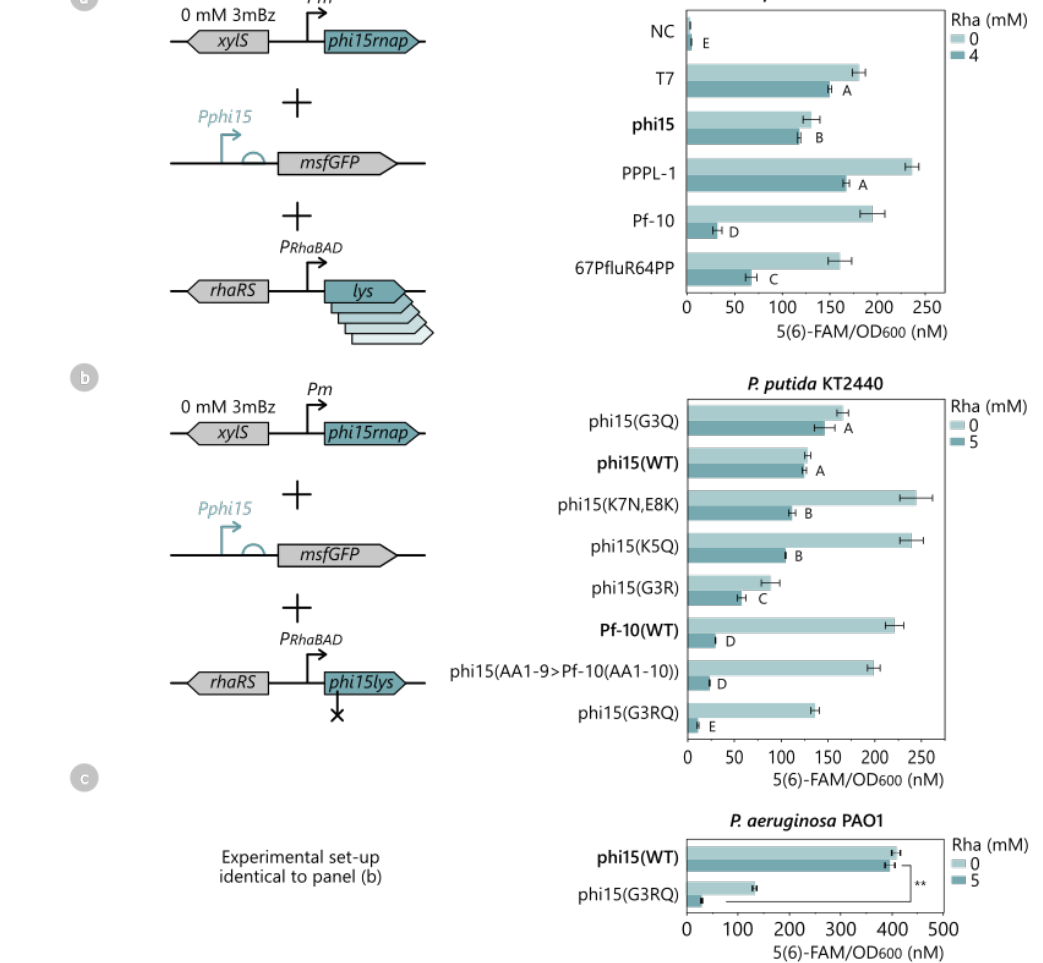
Figure 7. ( a ) Fluorescence intensity assay to analyze the inhibitory effect of different phage lysozymes on the phi15 RNAP. The phage lysozymes of T7, phi15, PPPL-1, Pf-10, 67PfluR64PP, and an empty pSTDes3 control vector (NC) were introduced in P. putida KT2440 together with the phi15 RNAP and Pphi15-msfGFP reporter construct. All samples were induced with 4 mM Rha at OD 600 0.3, after which the fluorescence intensity and cell growth were monitored every half hour for 12 h. Bars and error bars represent the mean 5(6)-FAM/OD 600 value and standard error of four biological replicates, respectively. Samples not connected by the same letters are significantly different (Tukey HSD, α = 0.05). ( b ) Similar fluorescence assay as ( a ) to assess the inhibitory strength of different phi15 lysozyme mutants on the phi15 RNAP. The wild-type phi15 and Pf-10 lysozymes (WT), as well as phi15 lysozyme mutants (AA1-9 > Pf10(AA1-10)), (G3R), (G3Q), (G3RQ), (K5Q), and (K7N,E8K), were introduced in P. putida , together with the phi15 RNAP and Pphi15-msfGFP reporter construct. All samples were induced with 5 mM Rha for 12 h. Bars and error bars represent the mean 5(6)-FAM/OD 600 value and standard error of four biological replicates, respectively. Samples not connected by the same letters are significantly different (Tukey HSD, α = 0.05). ( c ) Assessment of the inhibitory strength of the phi15 lysozyme (G3RQ) mutant in P. aeruginosa PAO1. The wild-type phi15 lysozyme (WT) and phi15 lysozyme mutant (G3RQ) were introduced in P. aeruginosa , together with the phi15 RNAP and Pphi15-msfGFP reporter construct, and induced with 5 mM Rha for 12 h. Bars and error bars represent the mean 5(6)-FAM/OD 600 value and standard error of four biological replicates, respectively. The significance level for a one-sided Student’s t -test is indicated, with **: p < 0.01. Full growth curves and fluorescence expression levels over time of ( a – c ) are available in Figure S9.